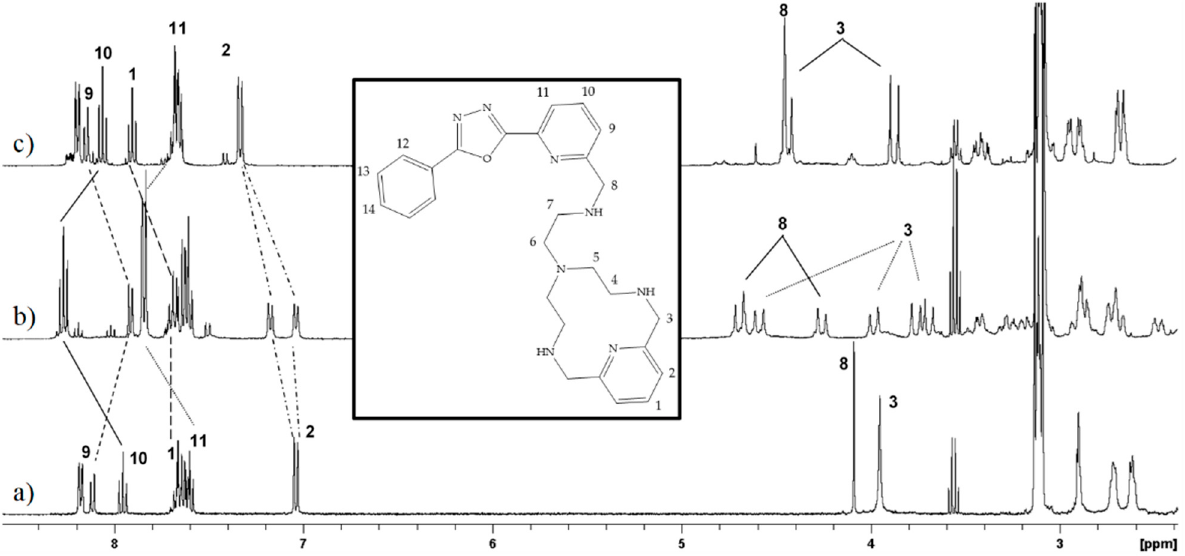
Figure 6. 1 H-NMR spectra of ( a ) ligand L, ( b ) ZnL complex and ( c ) ZnL complex in the presence of 1.0 equivalent of Bu 4 NCl, in CD 3 CN at 303 K. Inset: 1 H-NMR labeling scheme.